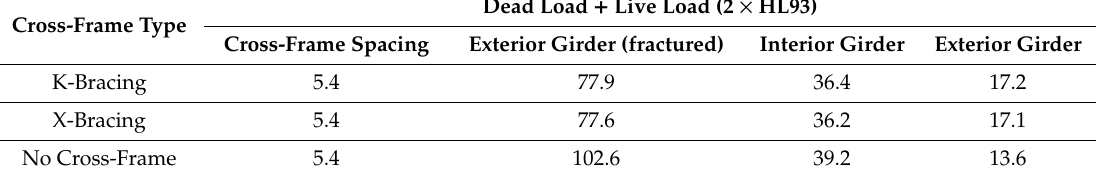
Table 4. Girder deflection at mid-span under the dead and 2 times HL93 loading for di ff erent cross-frame types.